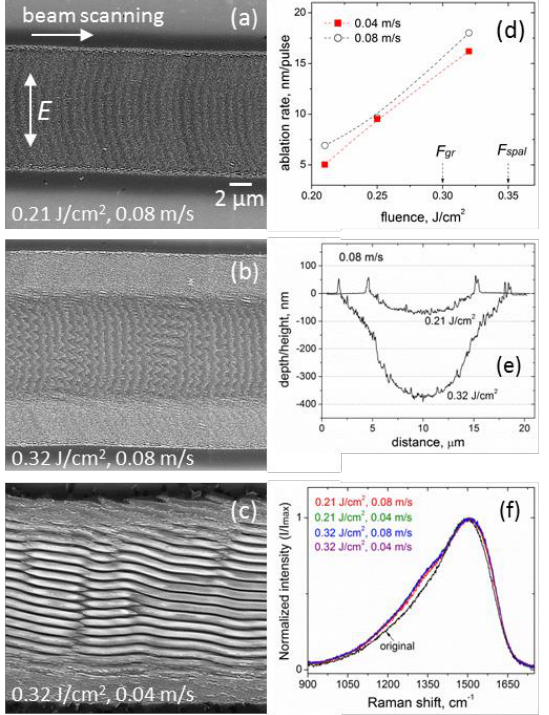
Figure 1. SEM images of microgrooves produced on the DLN film with a scanning beam of the IR fs-laser at ( a ) F = 0.21 J/cm 2 and V s = 0.08 m/s, ( b ) F = 0.32 J/cm 2 and V s = 0.08 m/s, ( c ) F = 0.32 J/cm 2 and V s = 0.04 m/s, the polarization direction is perpendicu- lar to the beam scanning direction; ( d ) the ablation rate vs. fluence for the two scanning velocities, arrows indicate the single-pulse graphitization and spallation thresholds; ( e ) AFM surface profiles of the microgrooves shown in ( a , b ); ( f ) Raman spectra (normalized to the maximum intensity) from central regions of the microgrooves, produced at F = 0.21 J/cm 2 and F = 0.32 J/cm 2 and two scanning velocities of 0.08 and 0.04